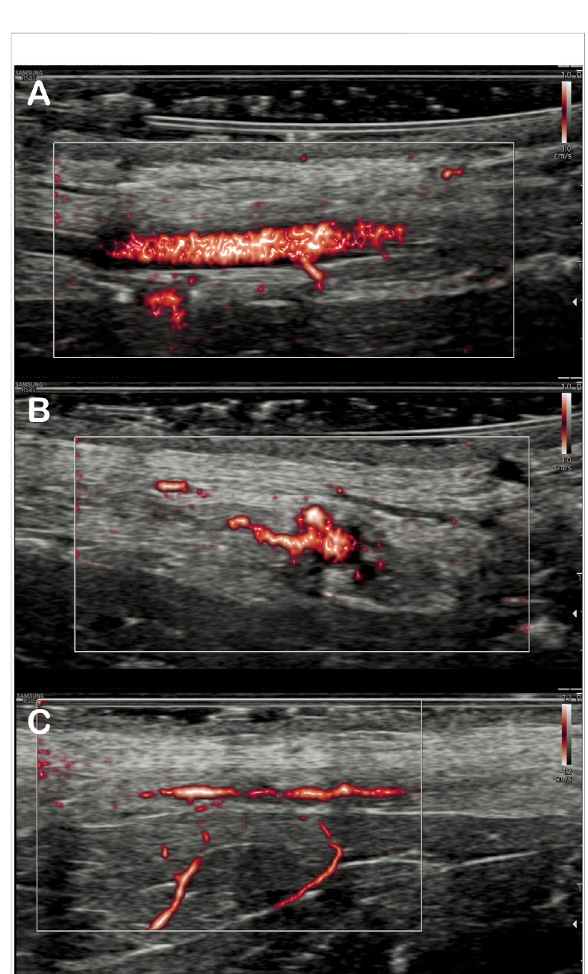
FIGURE 2 Imaging of the arterial branches of the saphenous artery by MV- fl ow. Detectionofsaphenousarterycollaterals inthe fl ap:The origin of inferior collateral is viewed in the longitudinal section (A) , and, for the same artery, more proximal collateral is detected in the transverse section (B) . Visualization of two deep inferior collaterals on another fl ap (C)